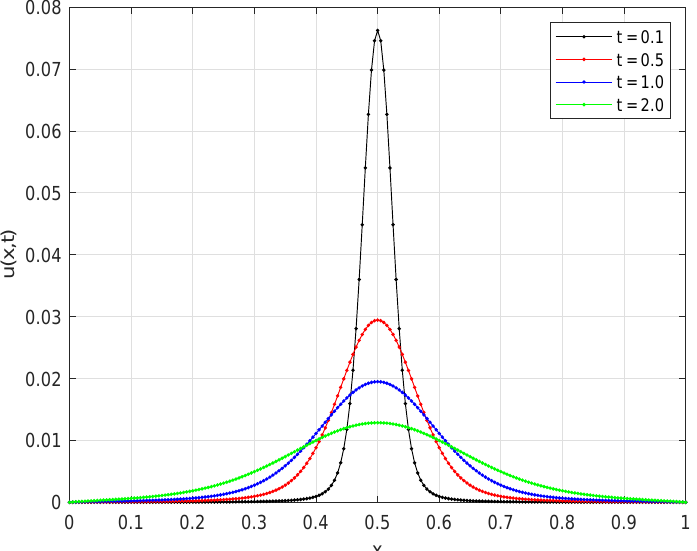
Figure 1. Example 1: Numerical solutions at different values of t using h = k = 1/200, l = 2, K = 1, A 1 = A 2 = 1, δ 1 = 1.255, and δ 2 = 1.75.